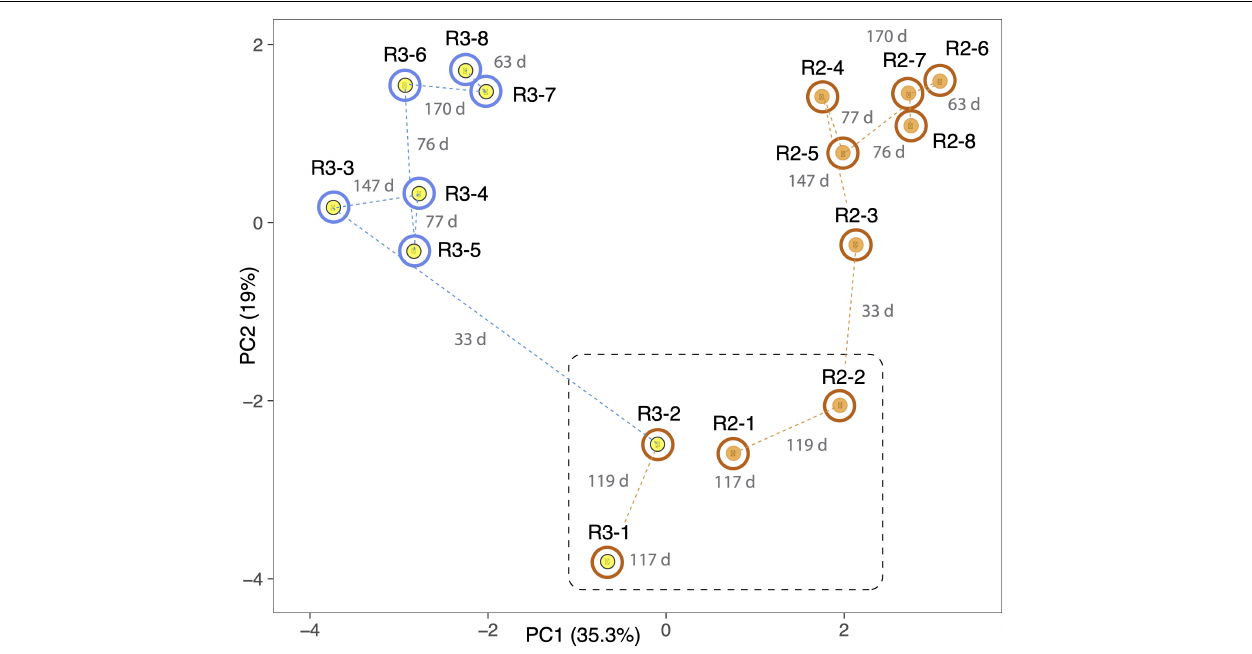
FIGURE 5 | Principal component analysis based on the relative abundances of 232 organisms (accounting for the most abundant 70–80% of the community) in R2 (orange dots) and R3 (yellow dots). Both reactors were ramped to 250 ppm SCN and held at this concentration for the duration of the experiment. Outer circles distinguish reactors receiving molasses (brown) from those receiving water (blue) at the time of sampling. The dashed black line separates samples taken prior to the switch of R3 to water. Dashed lines indicate sequential samples, and numbers in gray indicate the number of days (d) between sampling times. Note the strong and rapid deviation of community after the switch to water in R3. Samples 6, 7, and 8 in both reactors group away from 3, 4, and 5, suggesting that the community shift was incomplete at the middle time